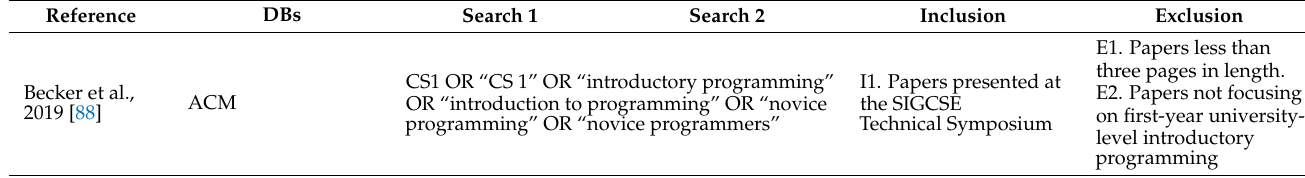
Table A2. Reference, Data Bases (DBs), Search (first and second), Inclusion and Exclusion